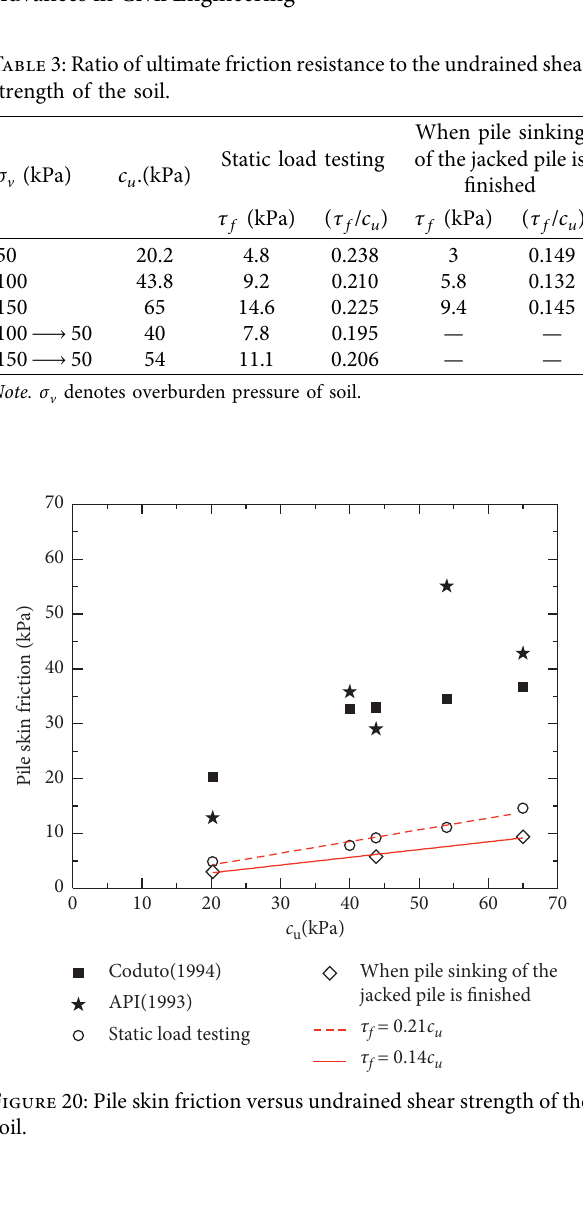
Table 4: Ratio of ultimate tip resistance to the undrained shear strength of the soil.